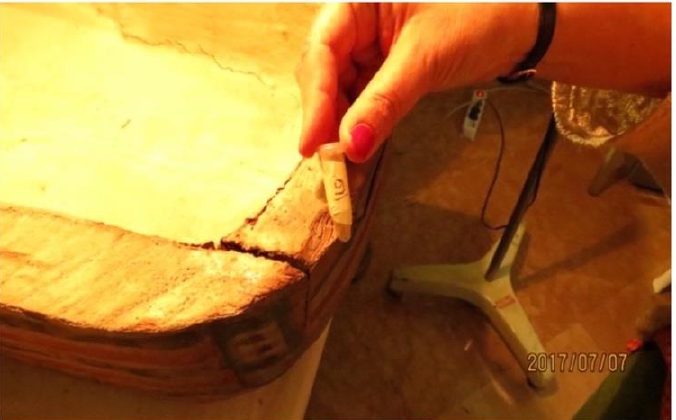
Figure 21. The traces of the handsaw on the surface of the flat edge of the box.